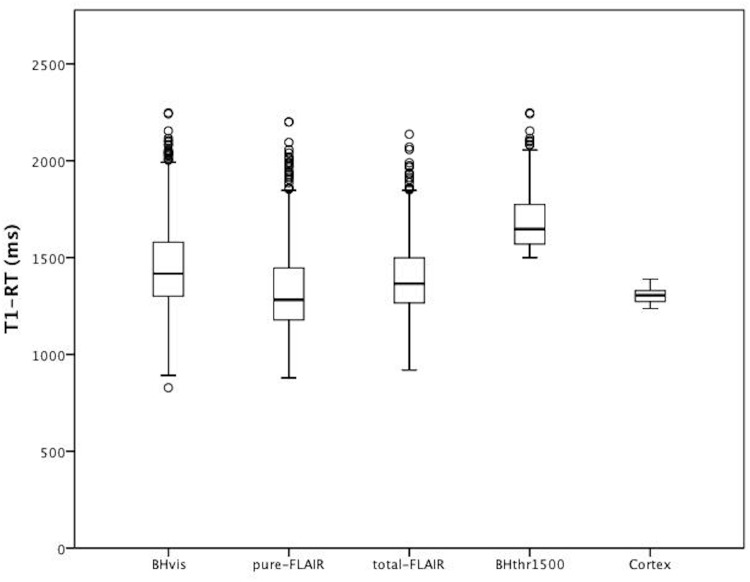
Box Plots showing T1-RT distribution in different lesion types.T1-RT = T1 relaxation time; total-FLAIR lesions = lesions from the semi-automatically segmented FLAIR lesions masks; pure-FLAIR lesions = lesions from the semi-automatically segmented FLAIR lesions masks that did not correspond to a BHvis or CE lesion; BHvis = manually segmented black holes without applied threshold, BHsthr1500 = manually segmented black holes with T1-RT higher than 1500 ms.